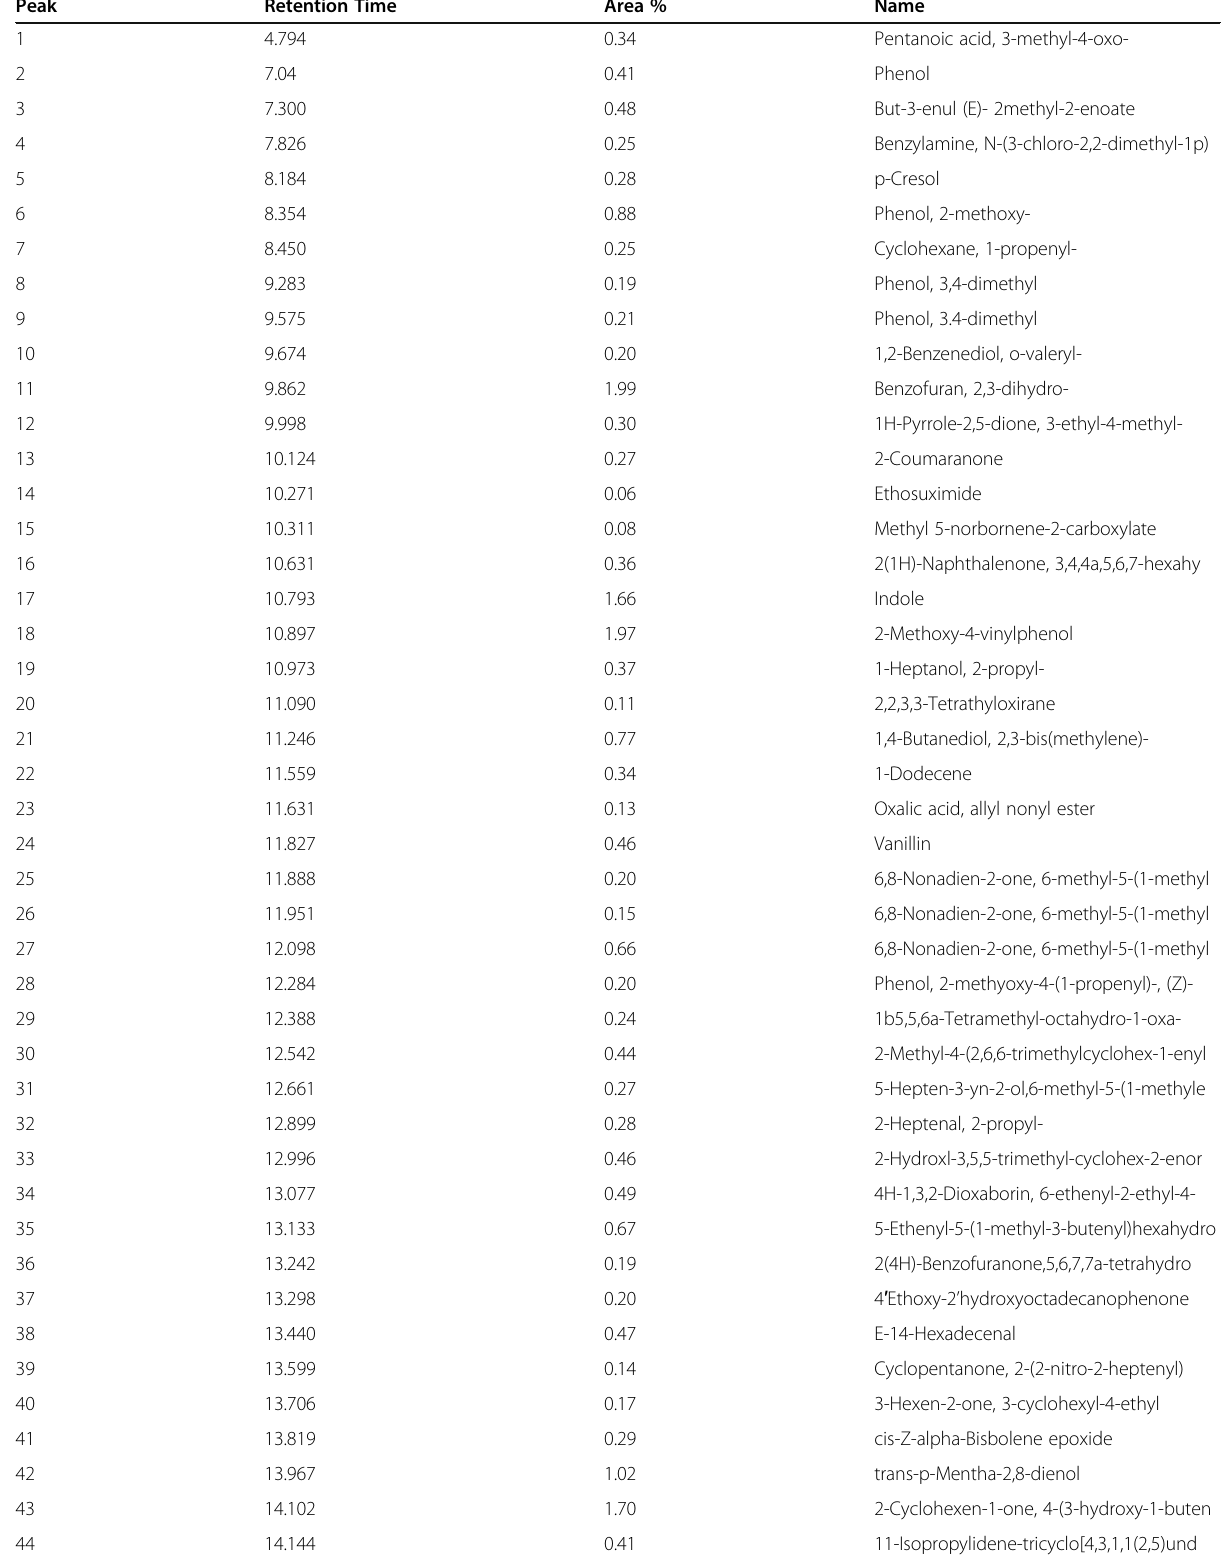
Table 7 Chemical composition of the n-butanol fraction of P. guineense following GC-MS analysis